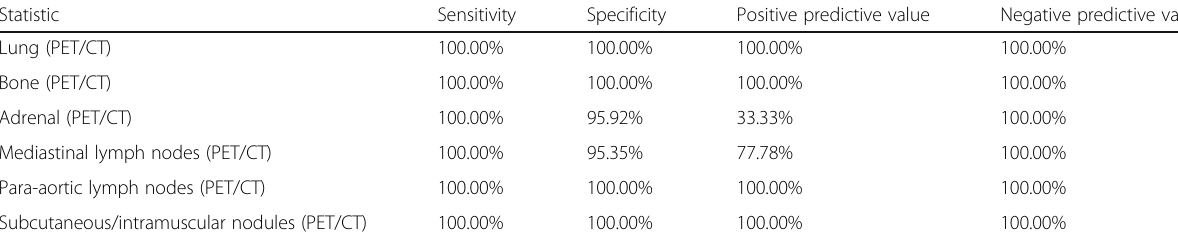
Table 5 Diagnostic performance of PET/CT at the distant metastatic subgroups Statistic